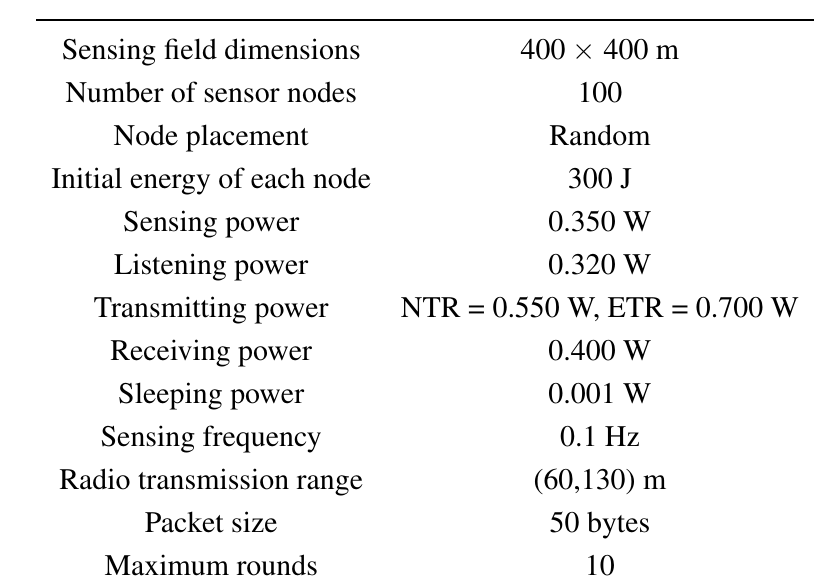
Table 2. Simulation parameters. NTR, normal transmission